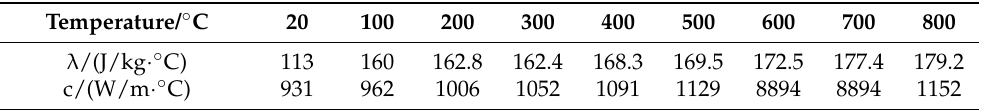
Table 1. Thermal property parameters of 6061 aluminum alloy.